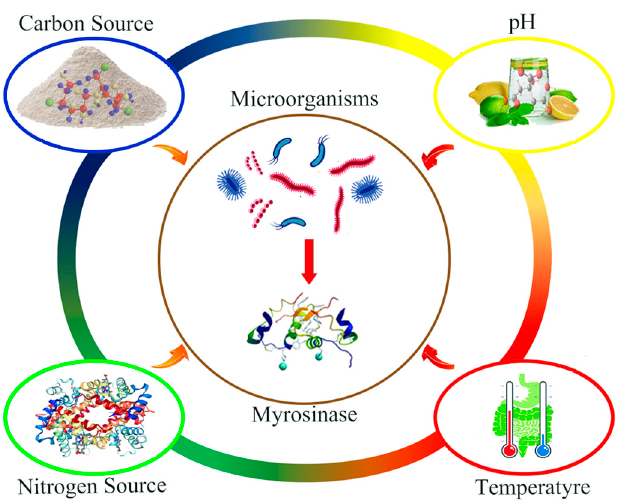
Figure 2. Factors affecting the synthesis of myrosinase by microorganisms.